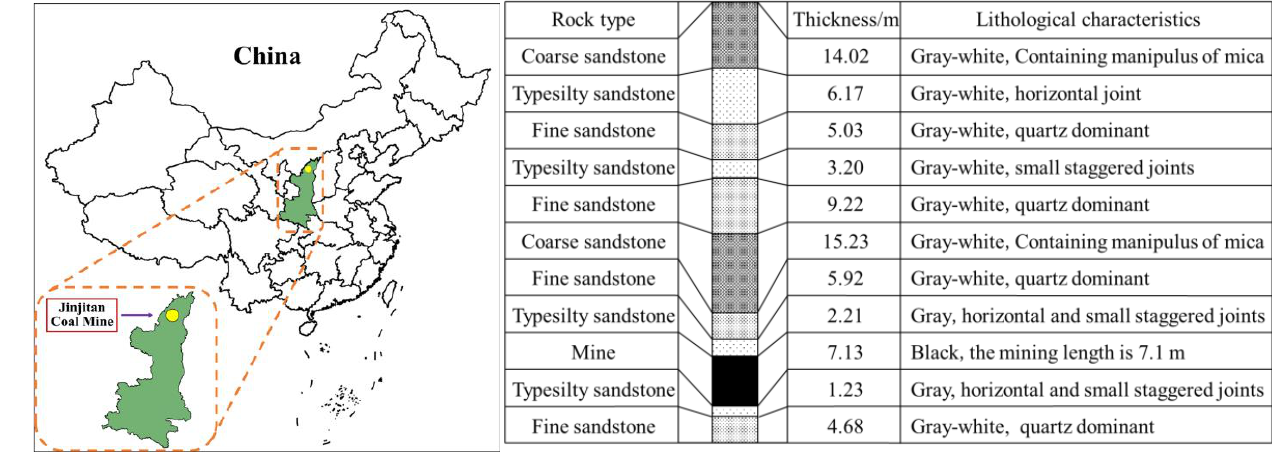
Figure 11. Location map of Jinjitan coal mine and strata map of mining face.